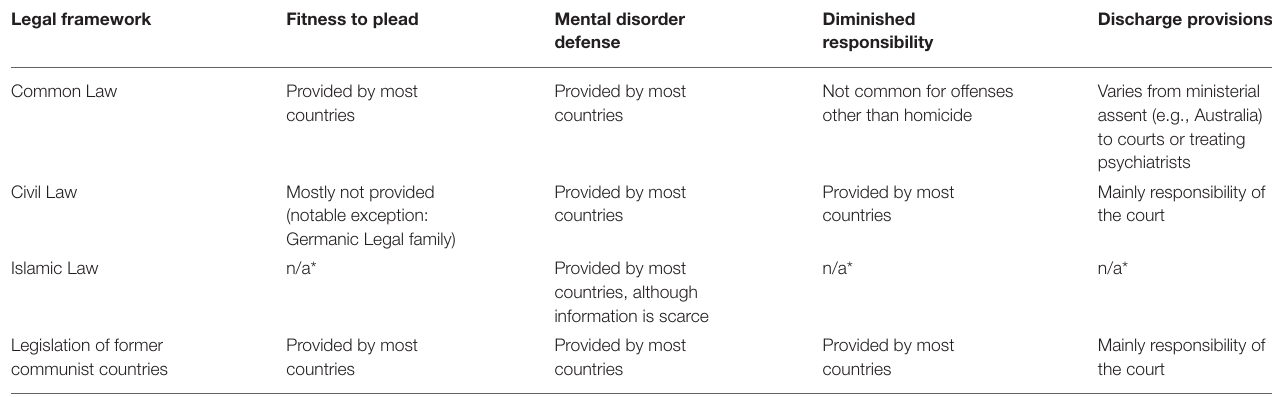
TABLE 1 | Fitness to plead, mental disorder defense, diminished responsibility, and discharge provisions by legal framework